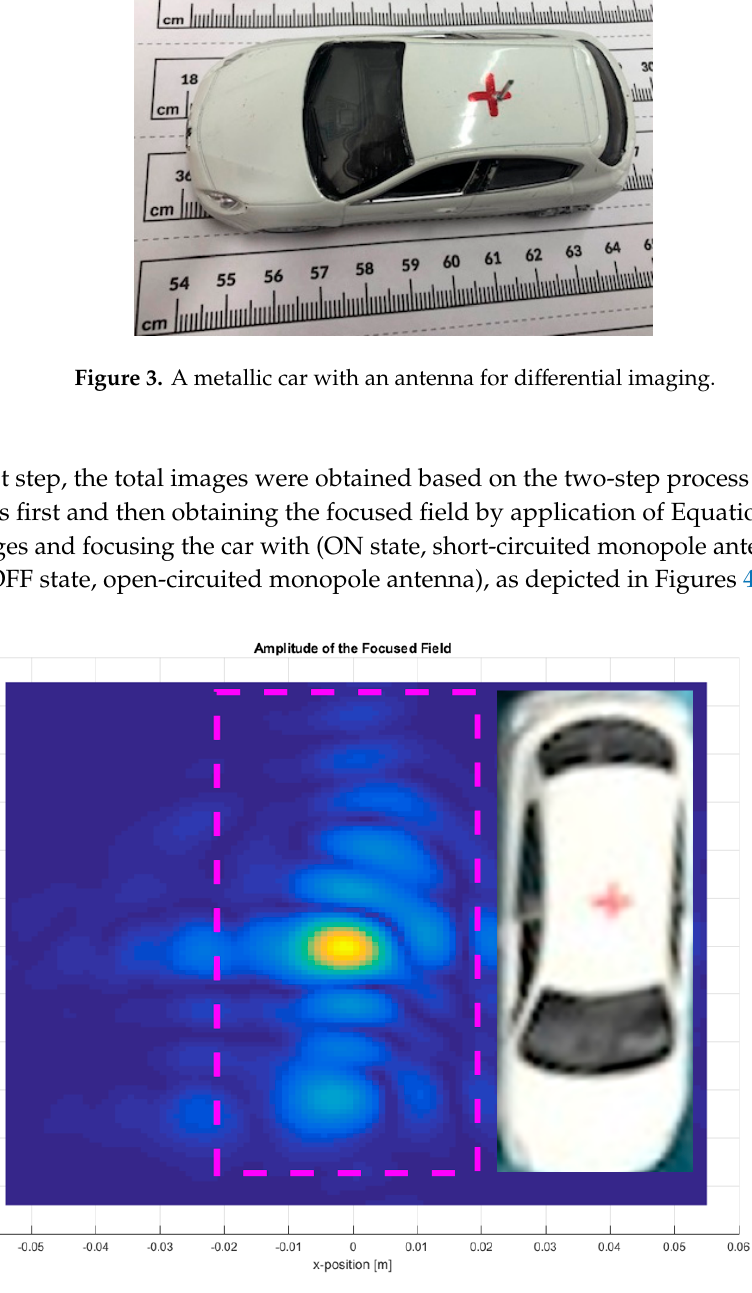
Figure 4. Focused field amplitude of the metallic car without an antenna. Frequency range: 295 GHz– 305 GHz (bandwidth (BW) = 10 GHz).